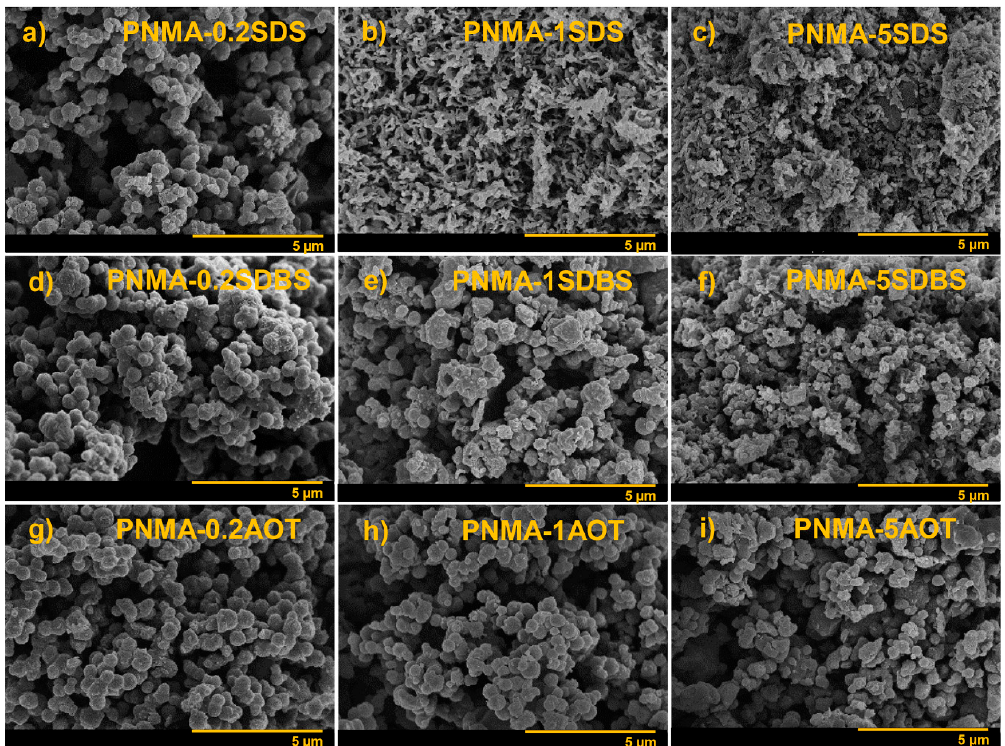
Figure 4. Morphology of PNMA synthesized in different anionic surfactants and at various concentrations: ( a ) PNMA-0.2SDS; ( b ) PNMA-1SDS; ( c ) PNMA-5SDS; ( d ) PNMA-0.2SDBS; ( e ) PNMA-1SDBS; ( f ) PNMA-5SDBS; ( g ) PNMA-0.2AOT; ( h ) PNMA-1AOT; and ( i ) PNMA-5AOT.